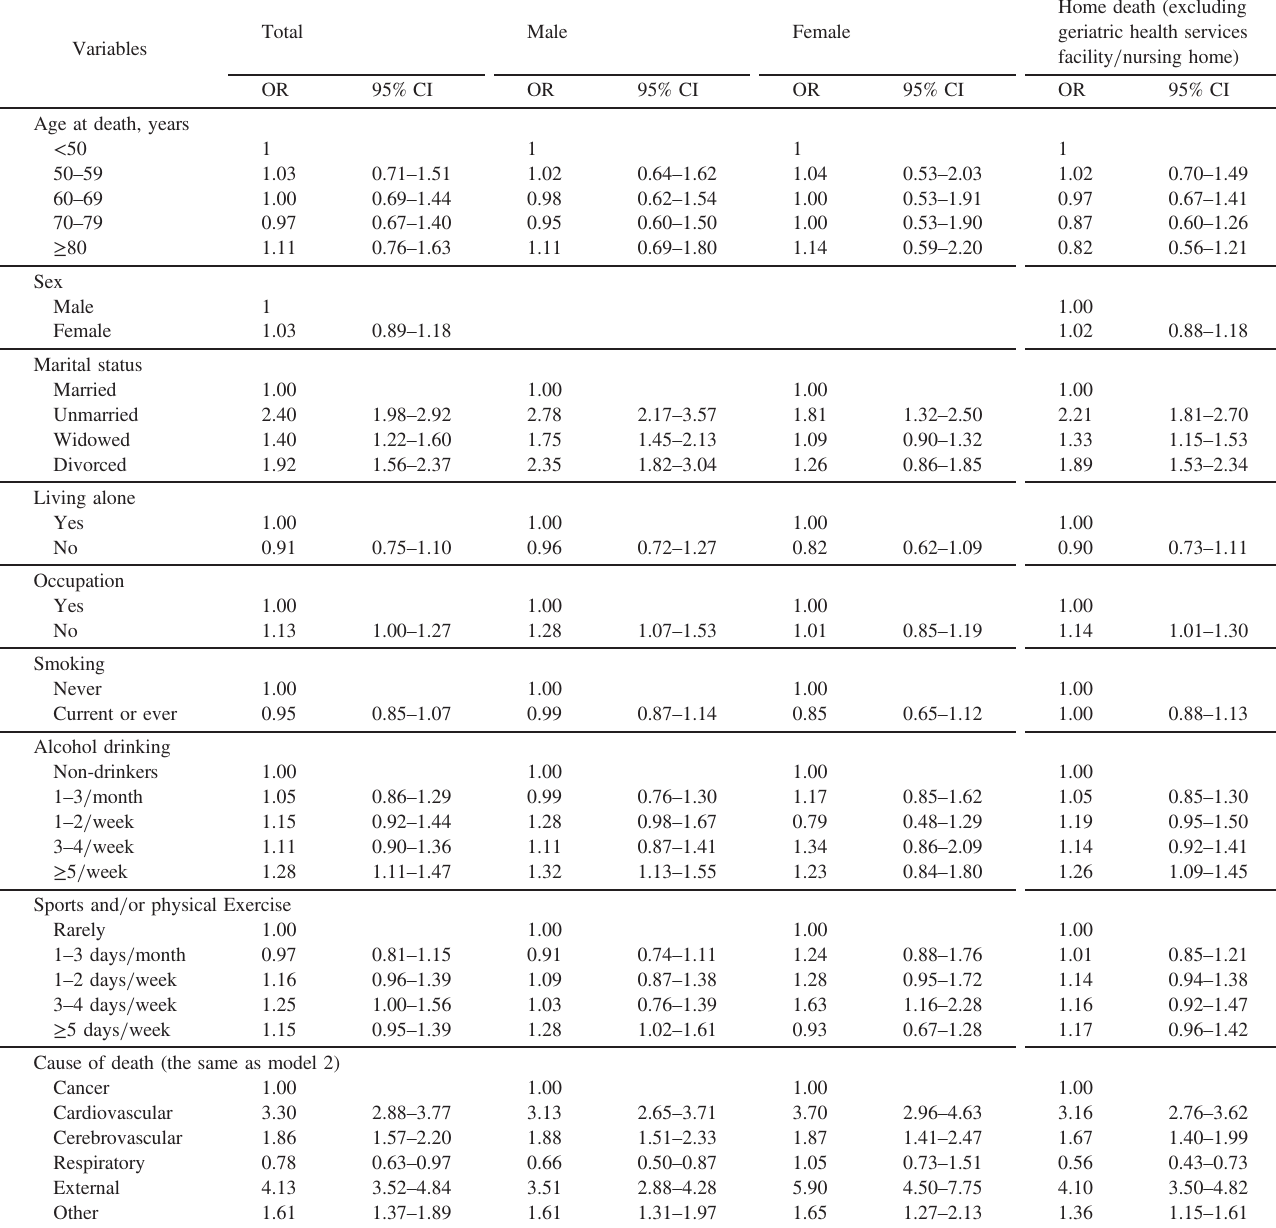
Table 2. Logistic regression analysis of liklihood of dying in a home